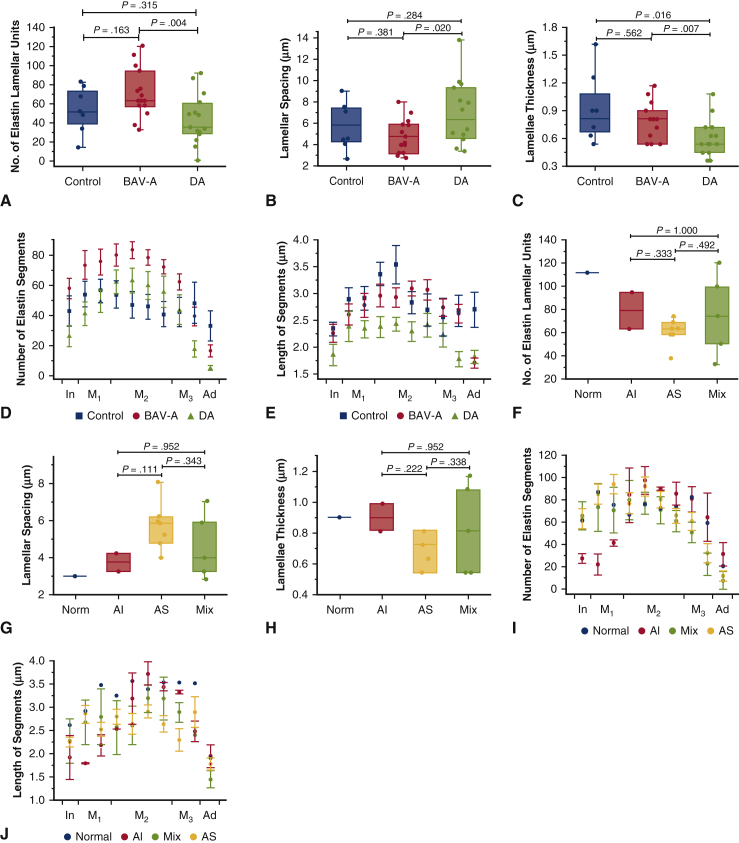
Quantitative analysis of elastin microstructure within control (n = 8), BAV-A (n = 15) and tricuspid aortic valve idiopathic DA (n = 15) aortic tissues. Quantitative analysis of elastin microstructure within bicuspid aortic valve aneurysm aortic tissues with normal valve function (Norm; n = 1), AI (n = 2), AS (n = 7), and a mixture of AI and AS (Mix; n = 5) are also shown F-J. Data in A-C and F-H were represented as box plots and data overlaid with upper and lower borders of the box to represent the upper and lower quartiles, and the middle horizontal line to represent the median. The upper and lower whiskers represent 5th and 95th percentile of the data. A, The number of elastin lamellar units; B, the lamellar spacing; and C, the thickness of the elastic lamellae were measured within the media. D, The number of elastin segments; and E, the length of the segments were measured over the entire tissue cross-section, expressed as mean ± standard error. Tissue cross-section was divided into 10 sections that covered innermost media (In), inner media (M1), middle media (M2), outer media (M3), and adventitia (Ad) layers. BAV-A had significantly more lamellar units with narrow lamellar spacing compared with DA. Control tissue had less lamellar units with wider lamellae spacing relative to BAV-A, although more units with narrower spacing relative to DA. DA had thinner lamellae compared with BAV-A and control. BAV-A and the control have similar elastin lamellae properties, although the number of segments differed between the groups. There were fewer short segments in DA relative to BAV-A and the control. Overall, we can note that although elastin segments were more uniformly distributed in the control, these segments were more compacted within the media of the aneurysmal tissues. All P values for elastin segments are presented in Tables E2 and E4. F-J, The same analysis as presented for A-E but within the BAV-A group only separating patients based on valve function. BAV-A, Bicuspid aortic valve aneurysm; DA, degenerative aneurysm; AI, aortic insufficiency; AS, aortic stenosis.